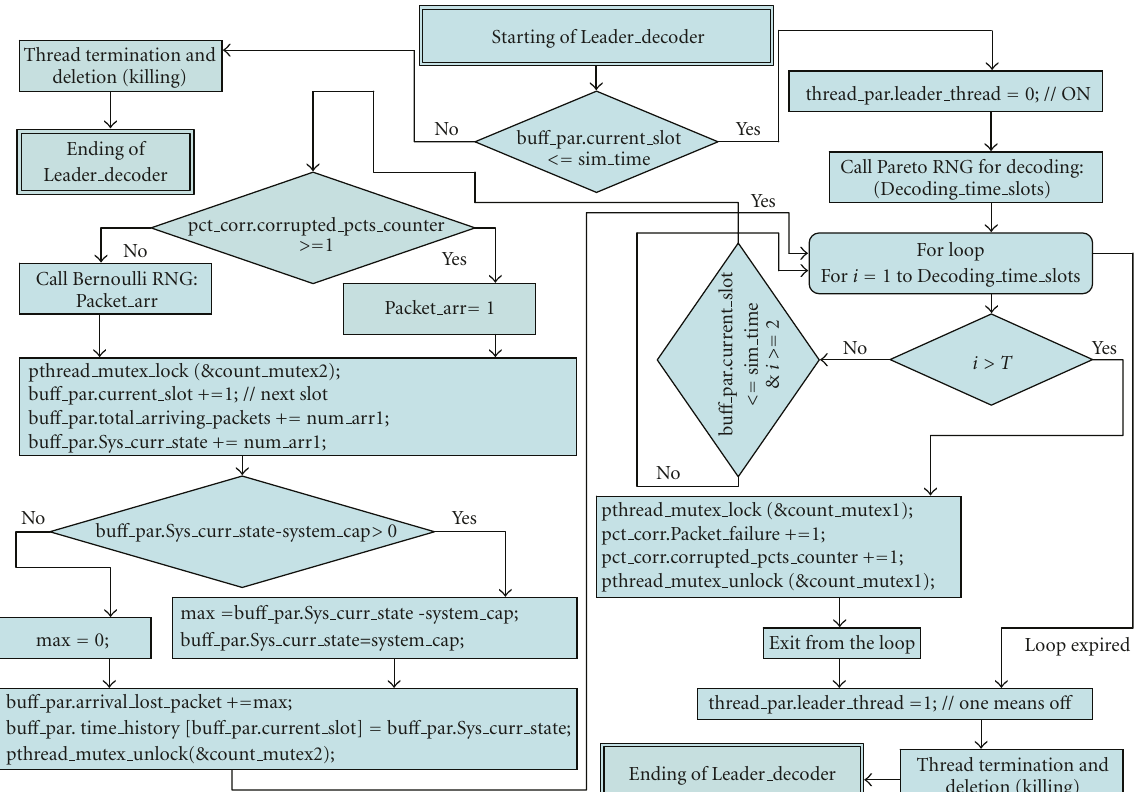
Figure 11: Major duties of the leader